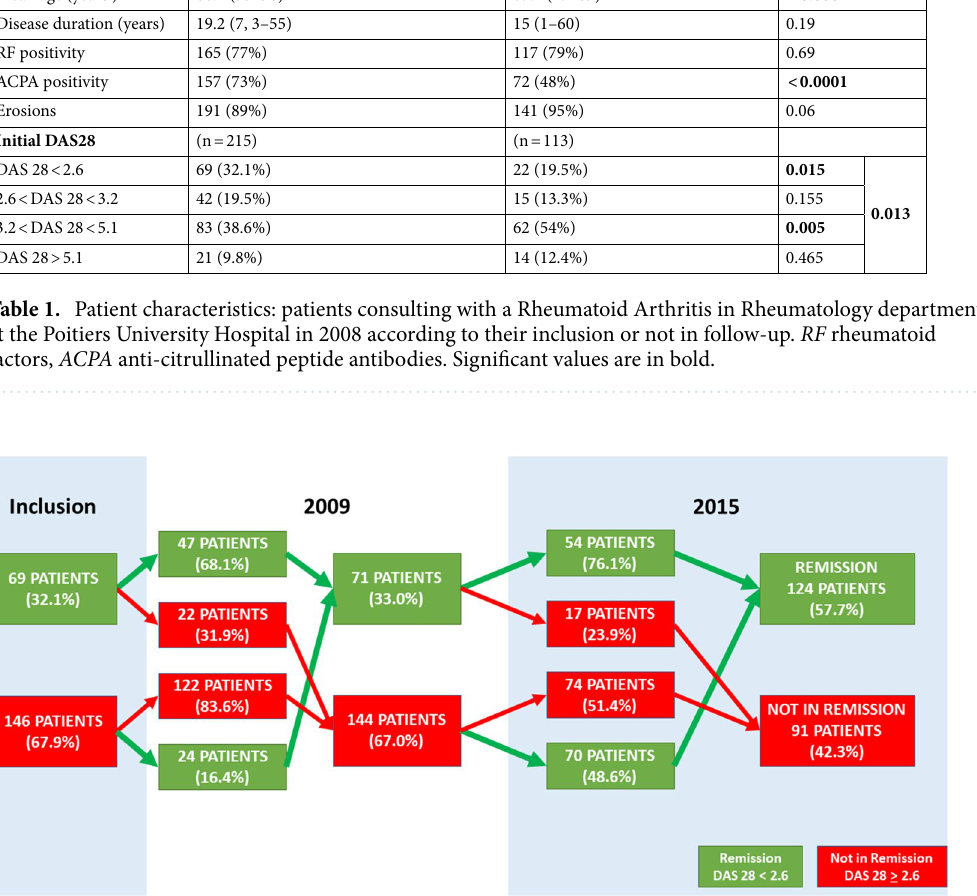
Figure 2. Description of remission and remission maintenance between 2009 and 2015: Patients (n = 215) consulting with Rheumatoid Arthritis in Rheumatology department at the Poitiers University Hospital in 2008 and follow-up until